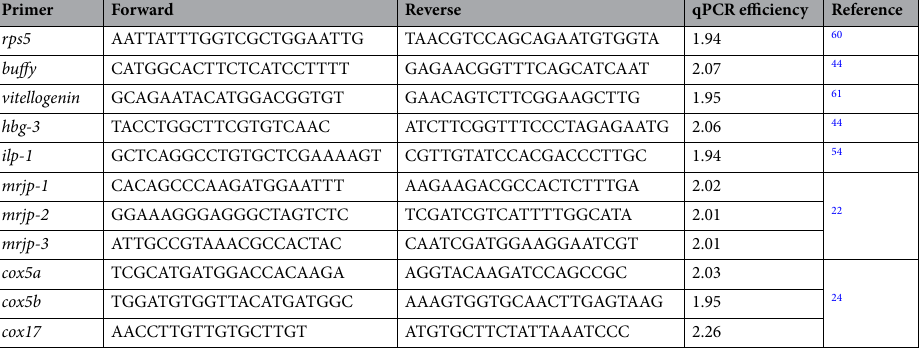
Table 3. Sequences and qPCR efficiency of analyzed